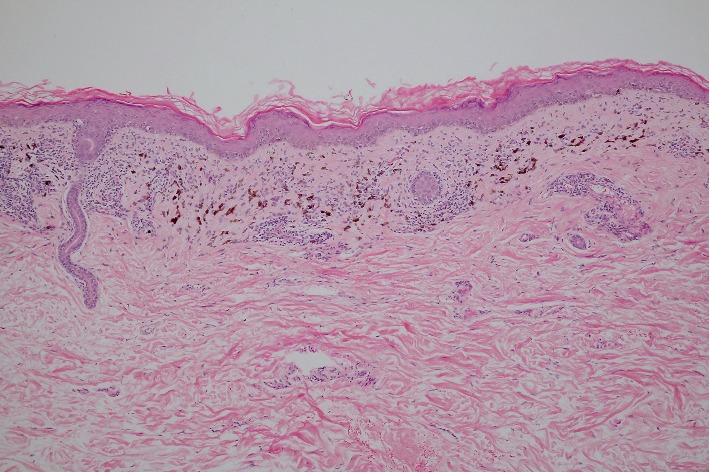
Histopathology of LPP patient demonstrating epidermal hyperkeratosis and focal hypergranulosis, focal lichenoid dermatitis, and moderate superficial perivascular lymphocytic infiltration with numerous dermal melanophages (hematoxylin-eosin stain, original magnification ×100).